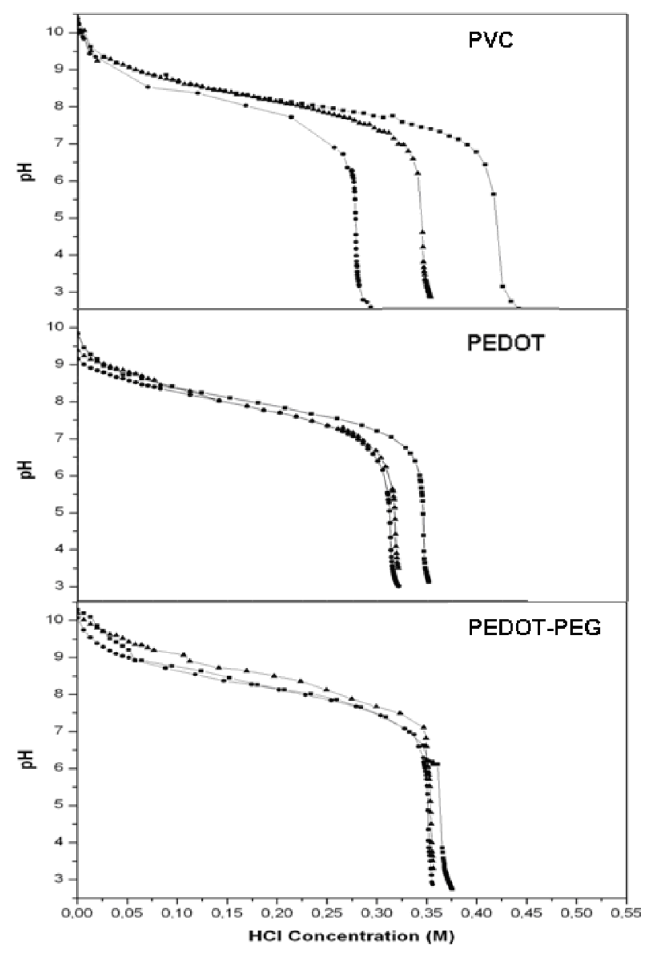
Figure 5. Repetitions (n = 3) of the potentiometric pH response for each sensor